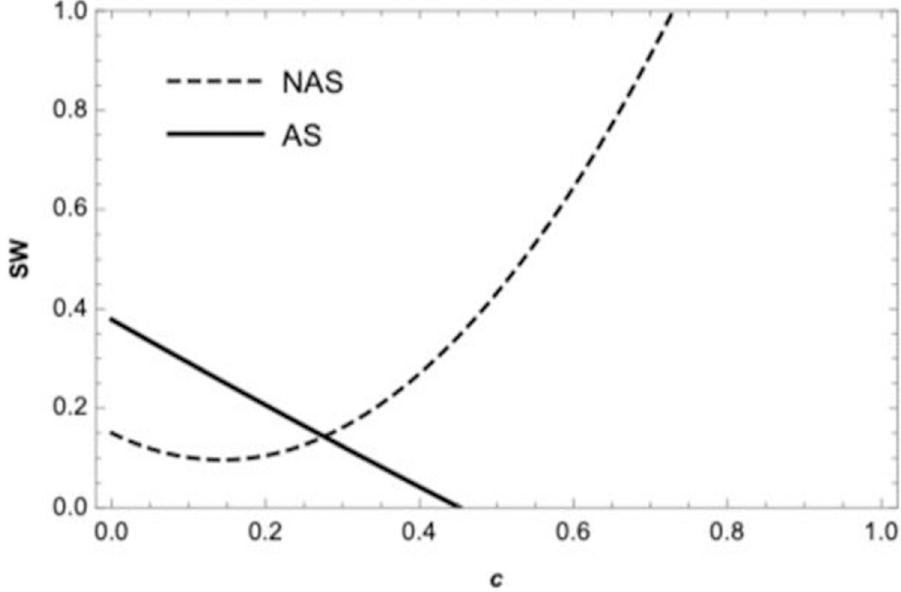
Fig 6. The social welfare in decentralized supply